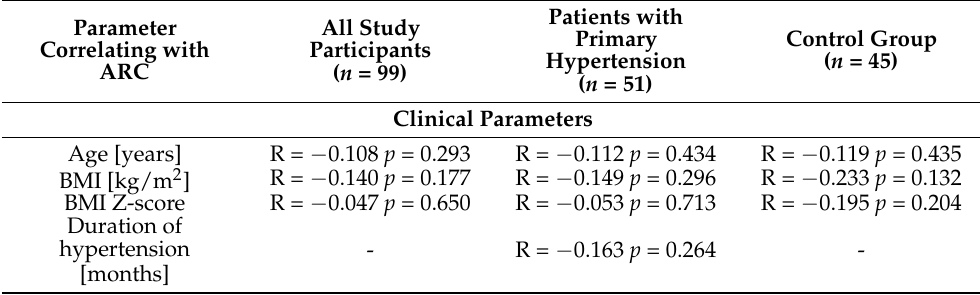
Table 4. Correlations of serum active renin concentration (ARC) with clinical and biochemical parameters in the examined population (R, P).